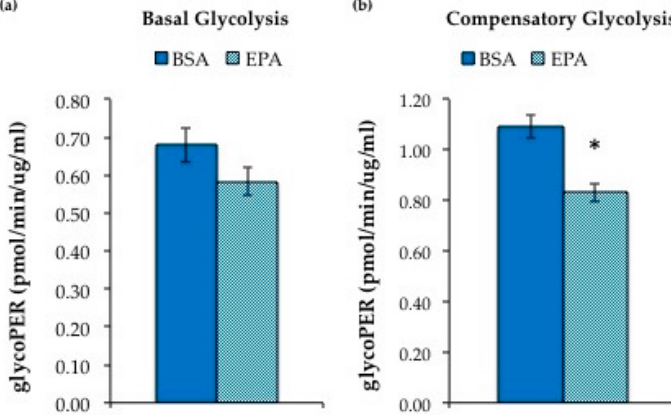
Figure 6. HepG2 cells treated with 50 µ M eicosapentaenoic acid (EPA) showed a lower glycolytic phenotype compared to cells treated with bovine serum albumin (BSA). ( a ) Basal glycolysis was